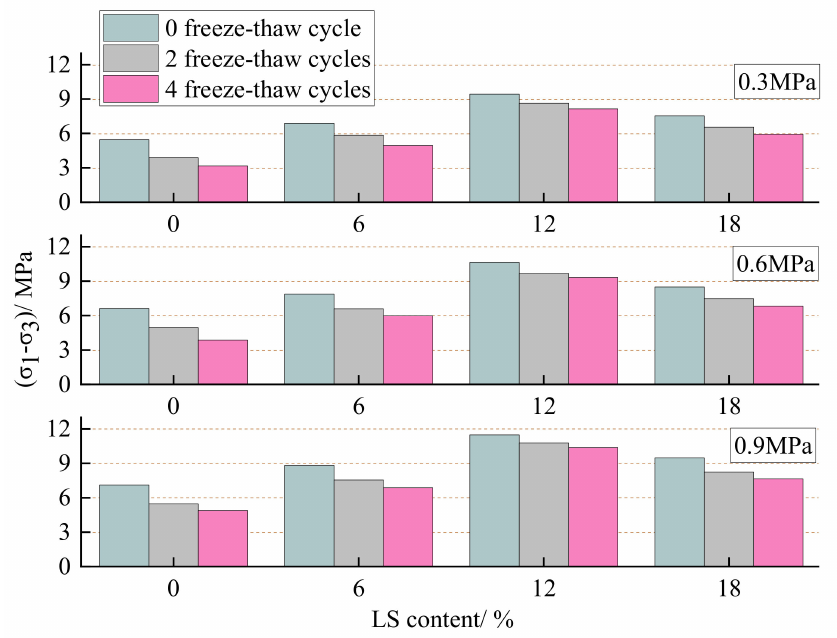
Figure 9. Effect of LS content on unconfined compression strength of cement-soil after freeze– thaw cycles.